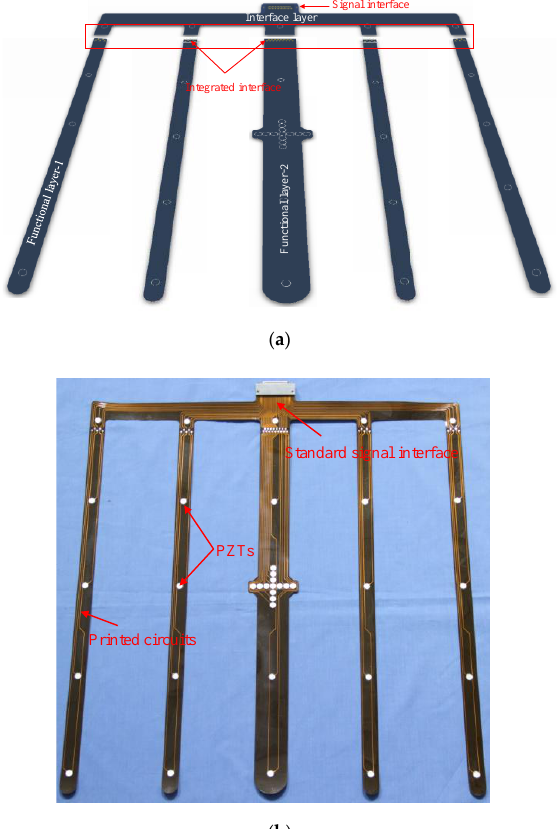
Figure 2. Example of a developed LPNL. ( a ) Schematic diagram of the recombination process. ( b ) The manufactured LPNL.